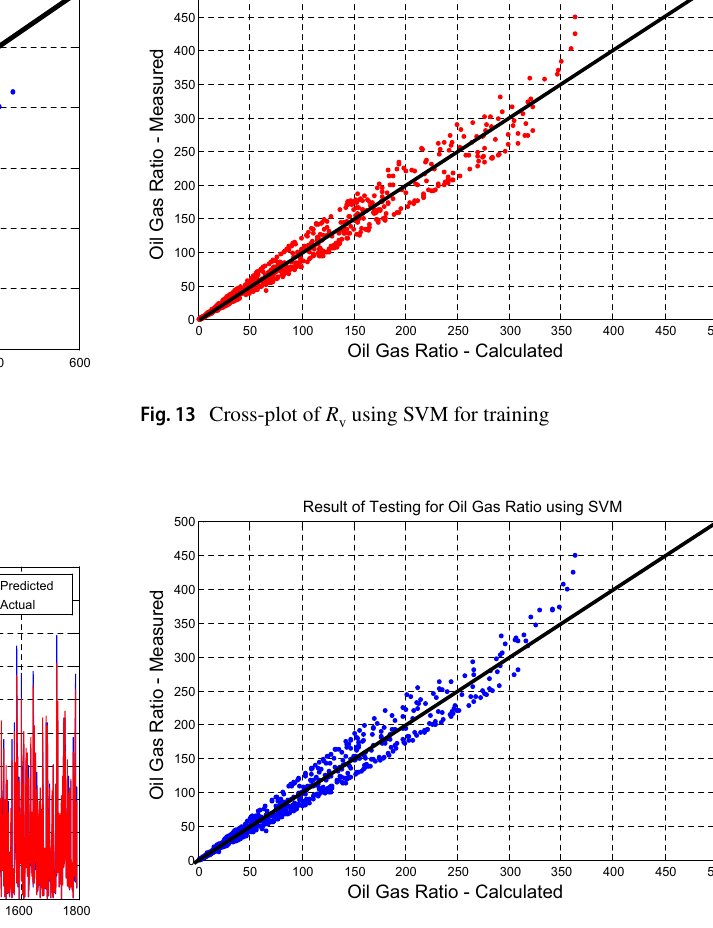
v as a function of data points using